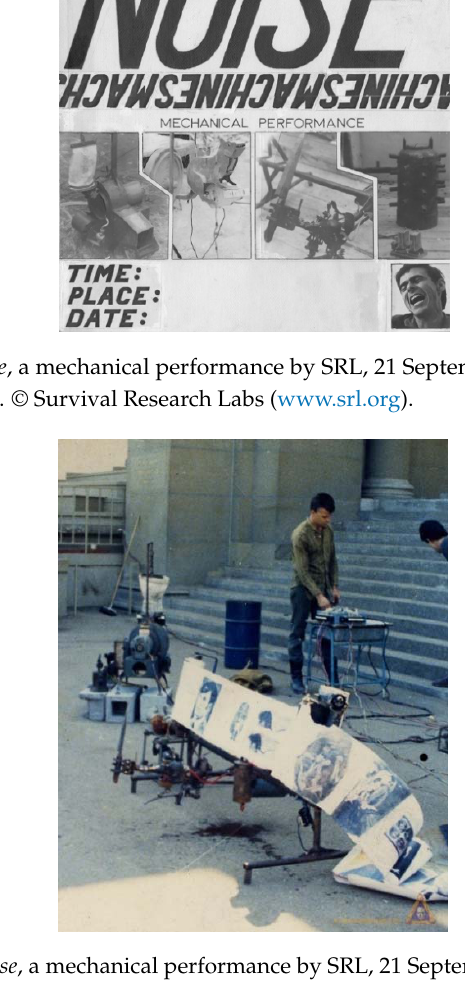
Figure 2. Scene from Noise , a mechanical performance by SRL, 21 September 1979, Golden Gate Park Bandshell, San Francisco. © Survival Research Labs.